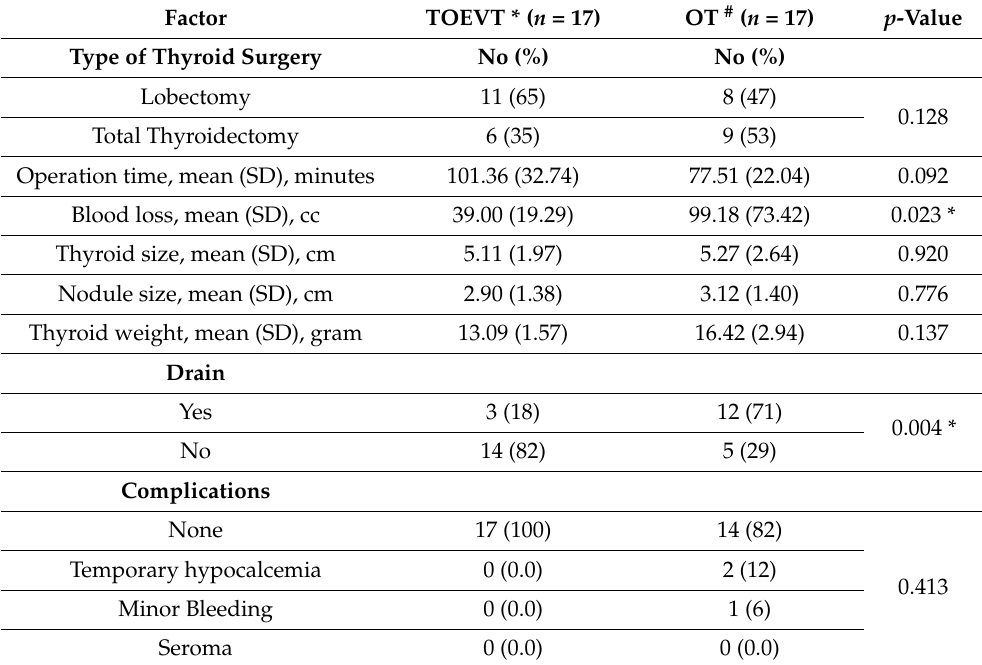
Table 5. A comparison of the surgical outcomes between transoral endoscopic vestibular and open thyroidectomy after propensity score matching ( n =